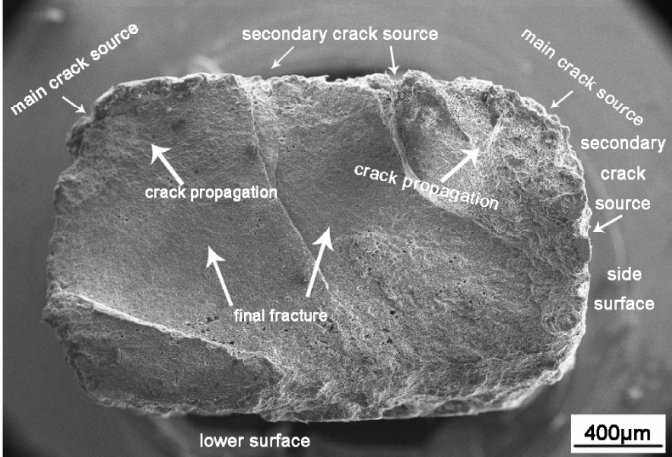
Figure 13. Corrosion fatigue fracture